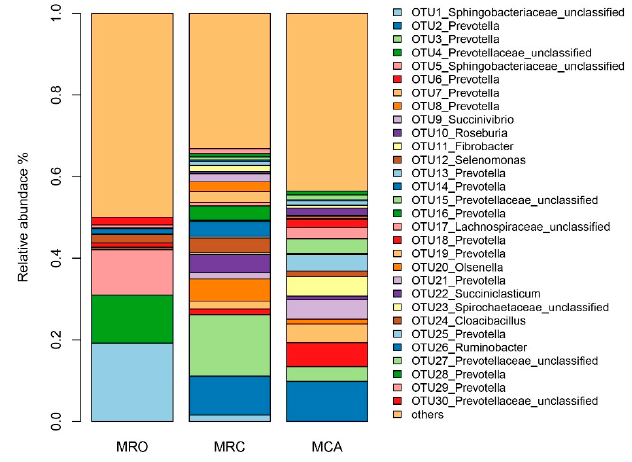
Figure 3. The top 30 OTUs in the three supplementary regimes. Each bar shows the average relative abundance of MRO, MRC and MCA groups. Each color represents the relative abundance of a bacterial taxon on the stacked bar chart. MRO = milk replacer, MRC = milk replacer + concentrate, MCA = milk replacer + concentrate +